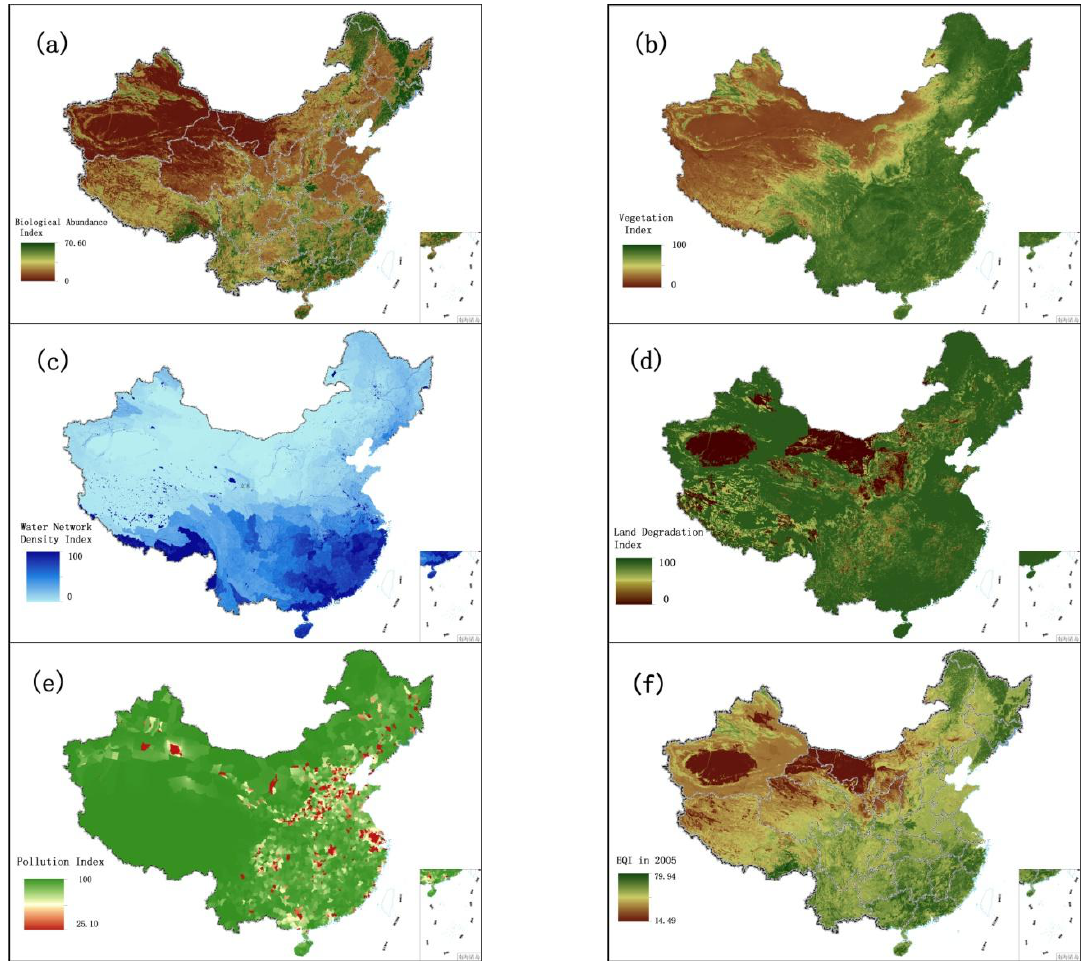
Figure 1. Ecological quality of environment over the Chinese mainland in